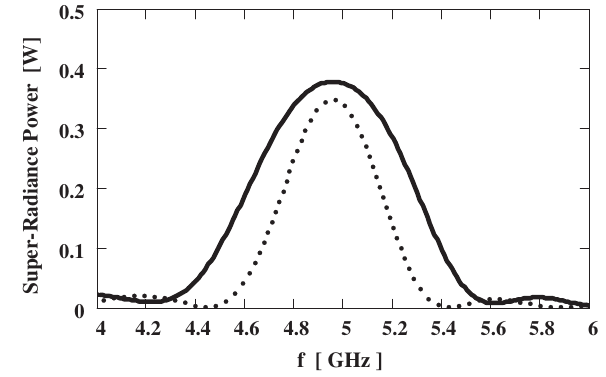
FIG. 3. Superradiance power vs frequency from a prebunched e -beam (for an e -beam current of 0.2 A, 70 keV e -beam energy, and a current modulation index of M J ¼ 0 . 2 ). The solid curve is plotted based on the analytical model developed in this paper [Eq. (33)] and the dashed curve is plotted based on simulations with FEL3D